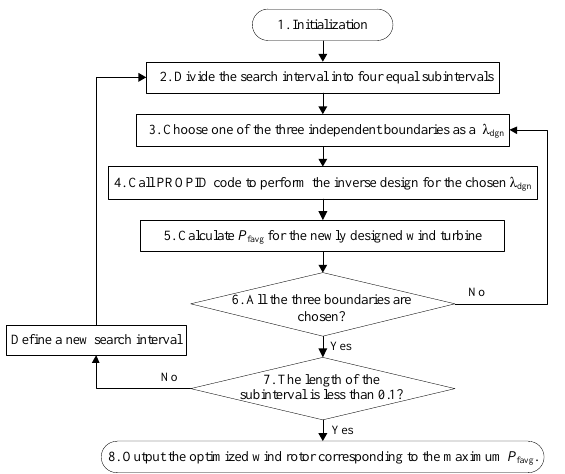
Figure 7. Flowchart of the aerodynamic optimization of the VSWT rotor.